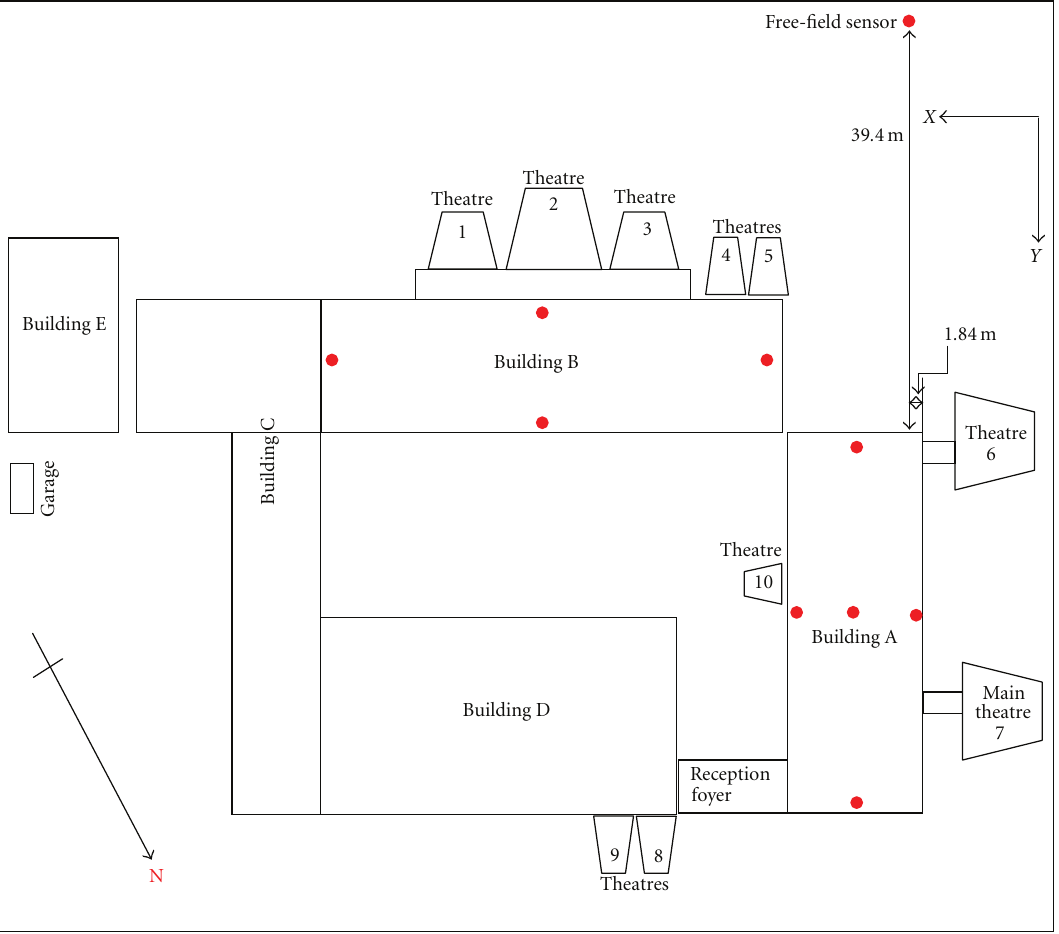
Figure 1: Layout of GNS Science building complex at Avalon (red dots show the approximate locations of